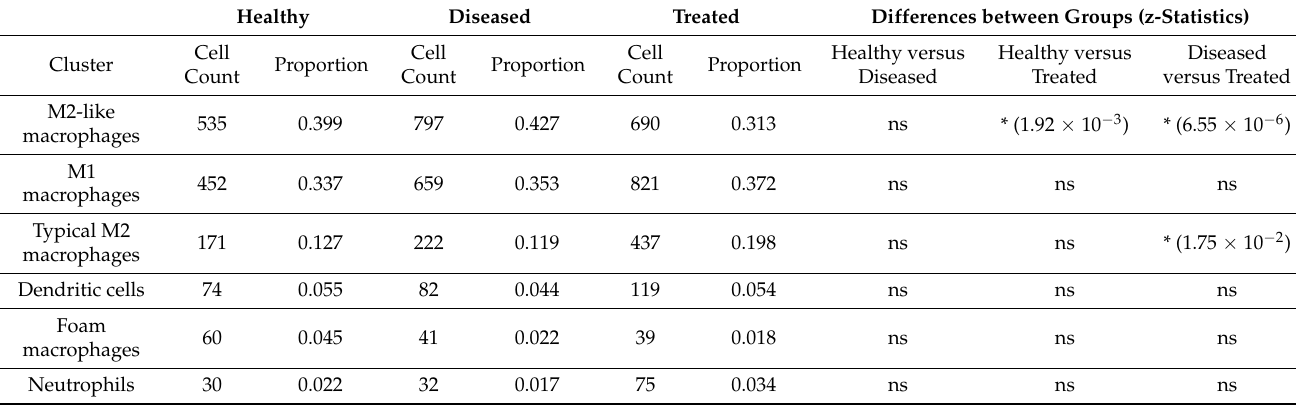
Table 3. Cell count and proportion in each defined myeloid cell population for each sample group. Healthy Diseased Treated Differences between Groups (z-Statistics)